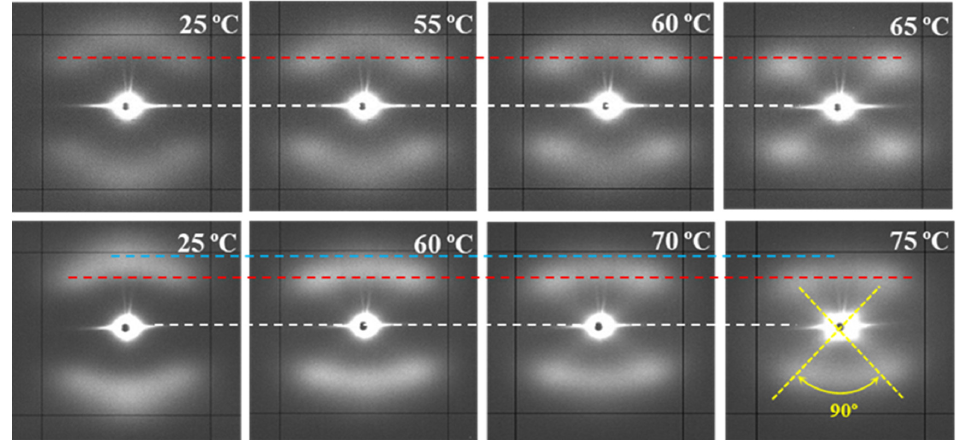
Figure 13. SAXS patterns of P4HB sutures exposed to hydrolytic media of pH 10, at 37 °C (top row) and pH 3, at 55 °C (bottom row) for 27 days. Patterns were recorded at the indicated temperatures during a heating run performed at 10 °C/min. Dashed lines are used as references for the position of the center of the pattern (white), off-meridional spots (red), and meridional spots (blue). The following features can be indicated: (a) Lamellae that constitute the core of the suture are more imperfect and therefore initiates melting at lower temperatures than the tilted ones. A